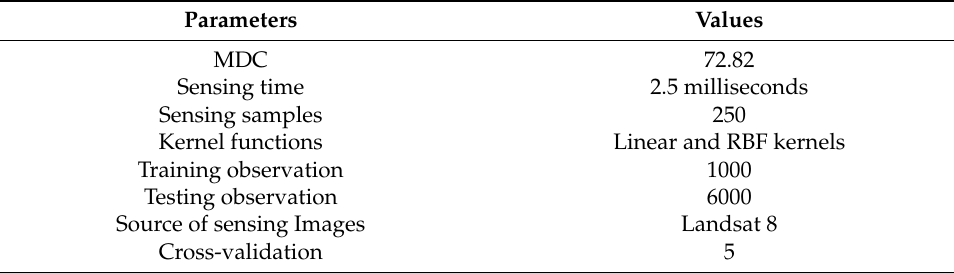
Table 3. Parameters used to conduct the